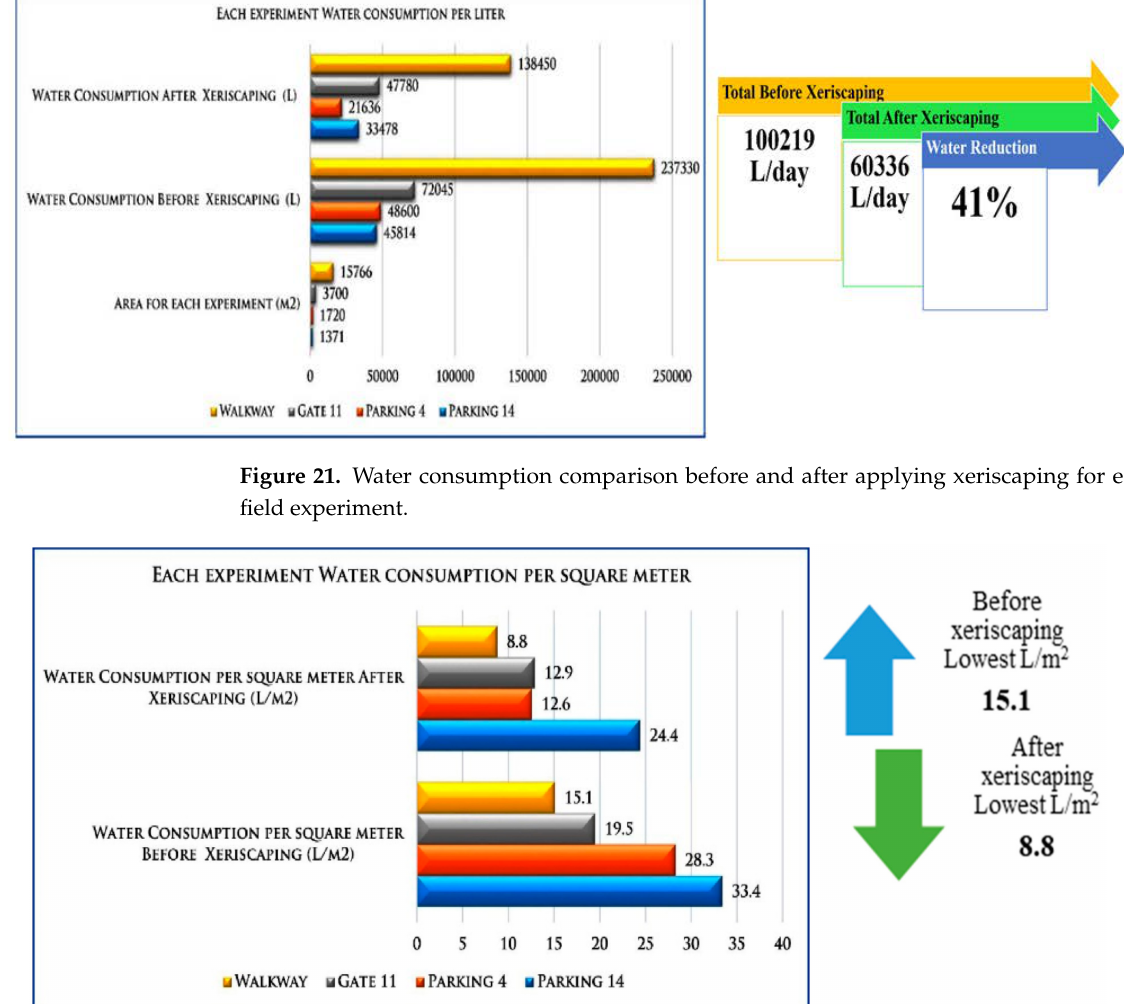
Figure 22. Water consumption comparison before and after applying xeriscaping for each study field experiment and water consumption per square meter L/m 2